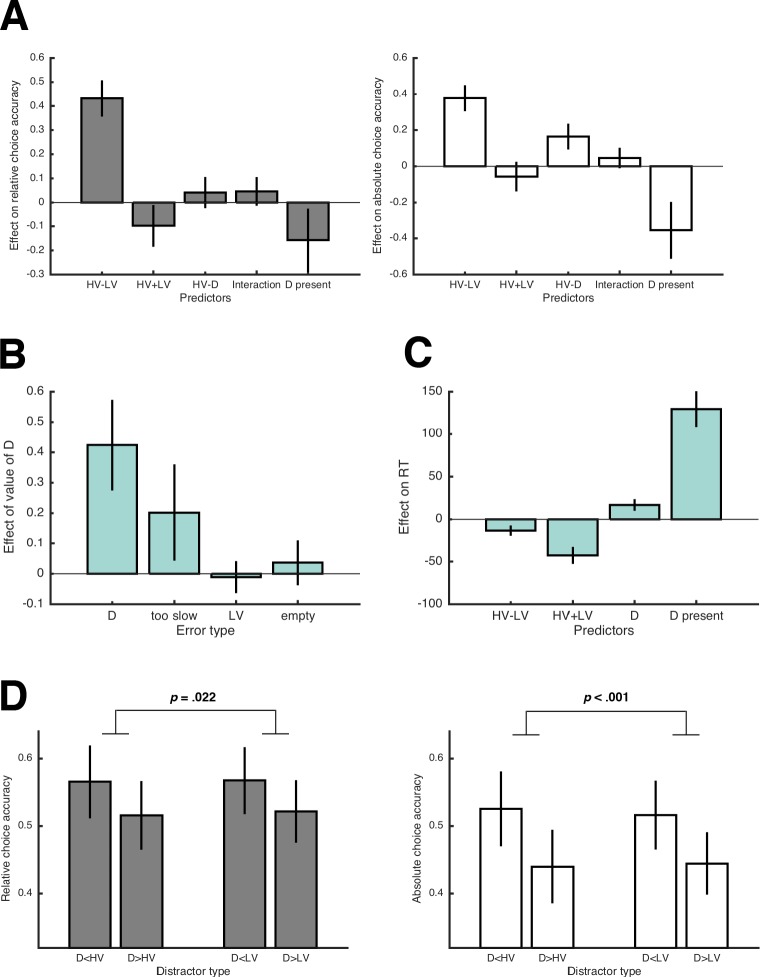
Results of Experiment 1.(A) Average regression coefficients of the predictor variables proposed by Chau2014 (including the HV-D predictor, which had a negative coefficient in their data) for relative and absolute choice accuracy (left and right panel, respectively). The term ‘interaction’ refers to the predictor variable (HV-LV)×(HV-D). Note that error bars in all figures represent 95% CIs, so that error bars not crossing the 0-line indicate significant effects. (B) Average coefficients of (separate) regression analyses testing how the value of D influenced different types of errors. (C) Average regression coefficients of predictor variables that influenced RT. (D) Relative and absolute choice accuracy in the novel trials (compare with predictions in Figure 1D). The comparatively low performance in the novel trials is due to HV and LV having very similar expected values (see Figure 1C).